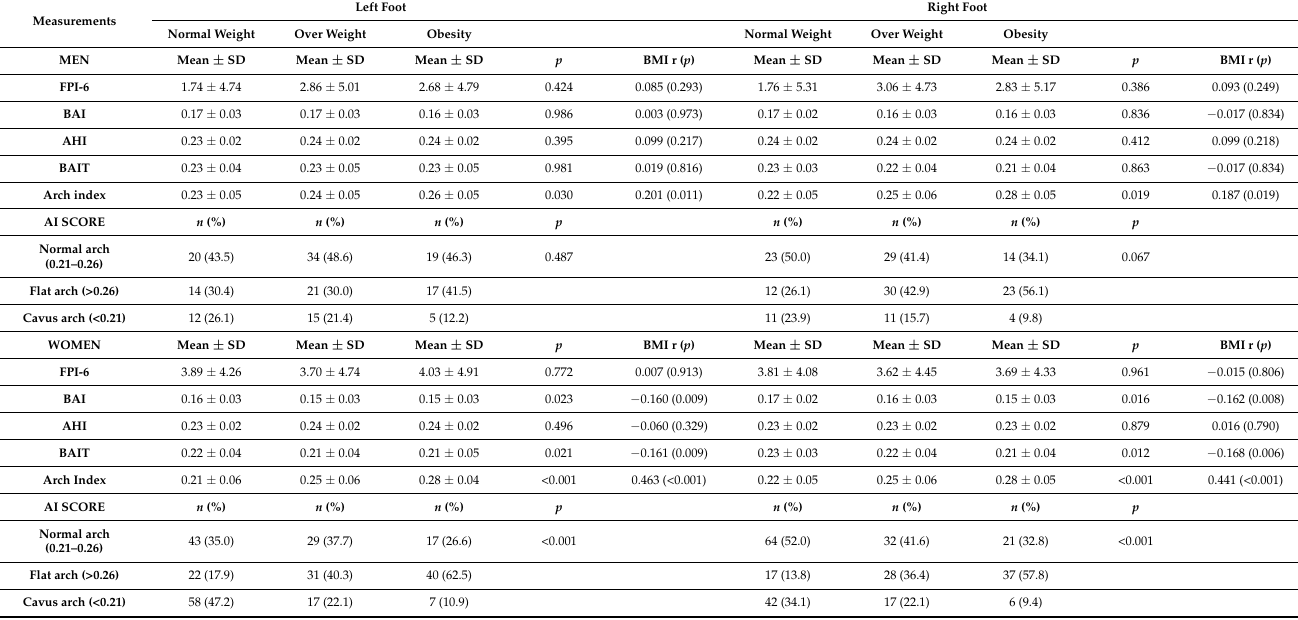
Table A6. Differences and correlation in medial longitudinal arch morphology according to body mass index by